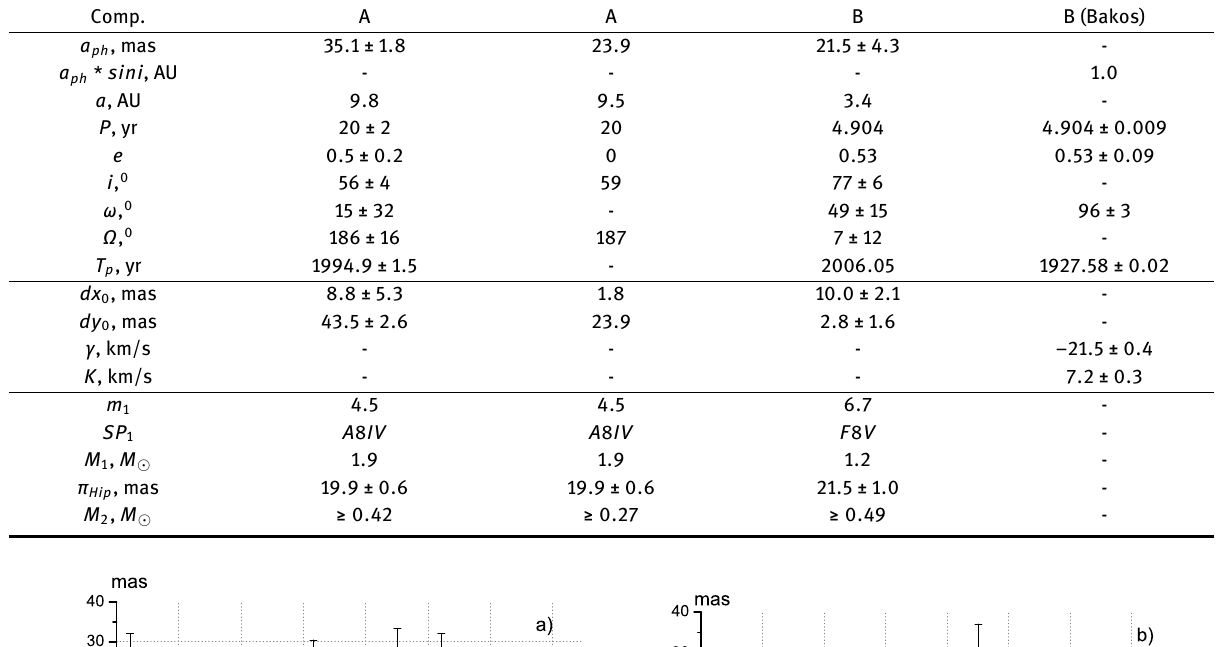
Table 1. The star κ Bootis. Orbits of photocenters of the components A and B. Comp.